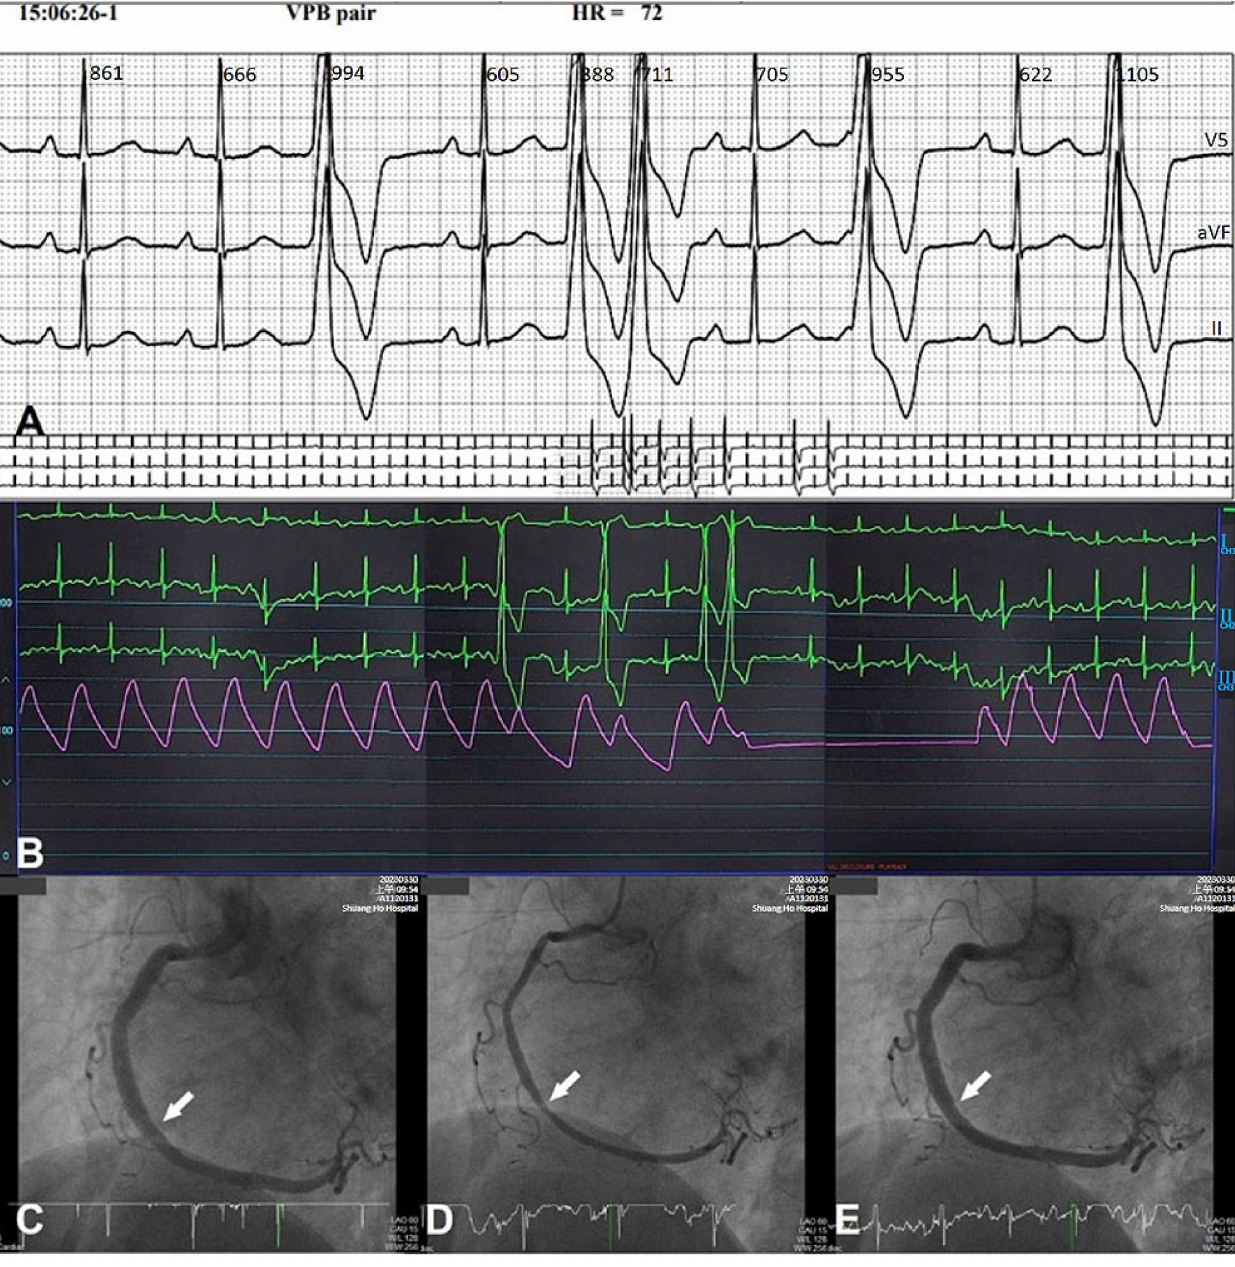
Figure 2. Epicardial CAS-induced ventricular ectopics: 24 h Holter monitor, electrocardiograms, pressure tracing, and right coronary arteriogram in a 53-year-old female presenting with frequent palpitation and unstable rest angina. ( A ) A 24 h Holter monitor showed sinus rhythm with runs of ventricular ectopics in singles and couplets without preceding ST segment changes; ( B ) simultaneous lead I, II, III electrocardiogram and systemic arterial pressure tracing during intracoronary ergonovine testing; ( C ) baseline angiographically normal right coronary artery with minimal plaquing; ( D ) middle spasm (arrow) immediately after intracoronary administration of 45 µ g ergonovine. Ventricular ectopics in singles and one couplet occurred at the same time; ( E ) the CAS and ventricular ectopics were relieved after intracoronary administration of 200 µ g nitroglycerin. The patient’s consciousness remained clear throughout the